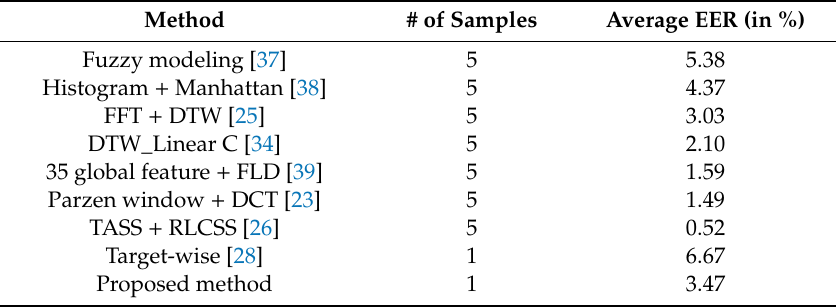
Table 6. Comparative studies of state-of-the-art methods implemented on SUSIG.